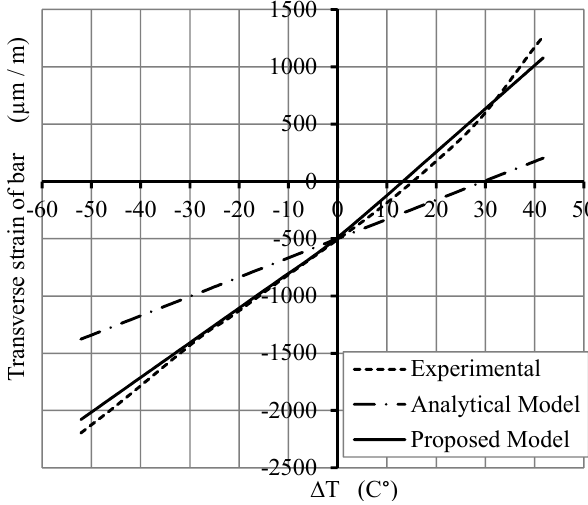
Figure 14. Transverse strain of FRP bars of slab SA.30.16—Experimental and analytical results comparison, c / d = 1.9. b